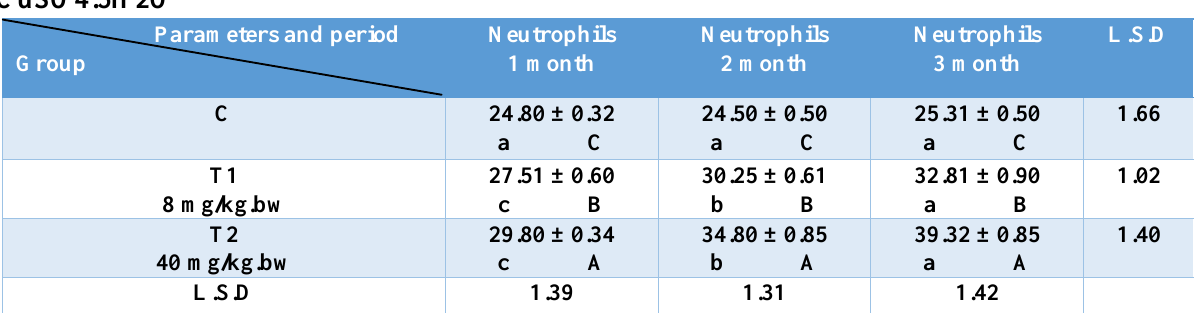
Table, 5: Values of Neutrophils (%) in blood of rats treated with different doses of CuSO4.5H2O